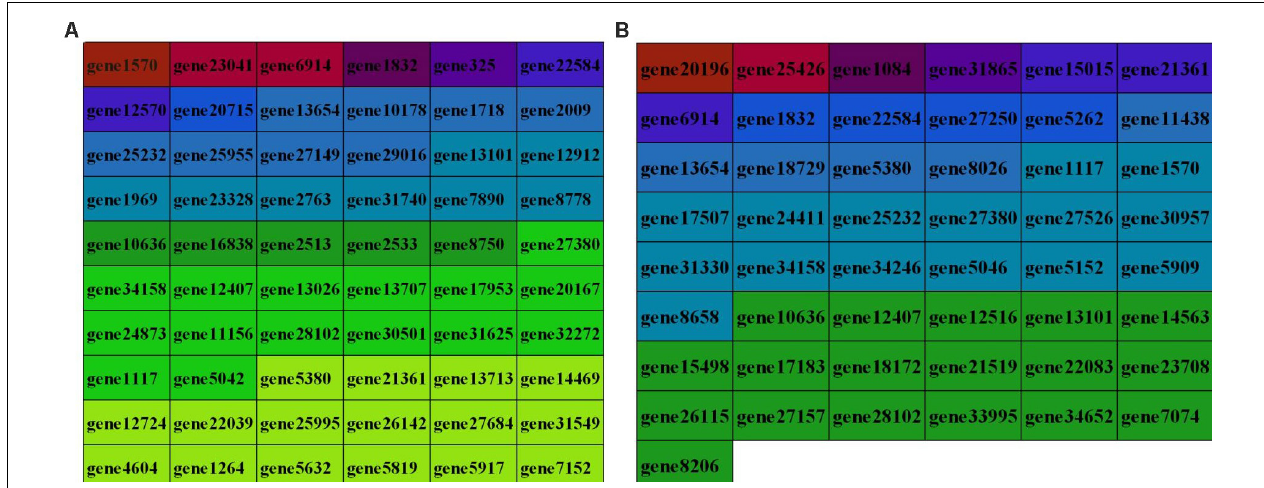
FIGURE 5 | Enrichment degree of the identified parental genes in GO terms (A) and KEGG pathways (B) . Different colors indicate the different enrichment degrees of parental genes in terms related to muscle growth and development. The darker the color, the higher the enrichment degree and the lighter the color, the lower the enrichment degree; the enrichment degree of source genes is arranged from high at the top to low at the bottom.